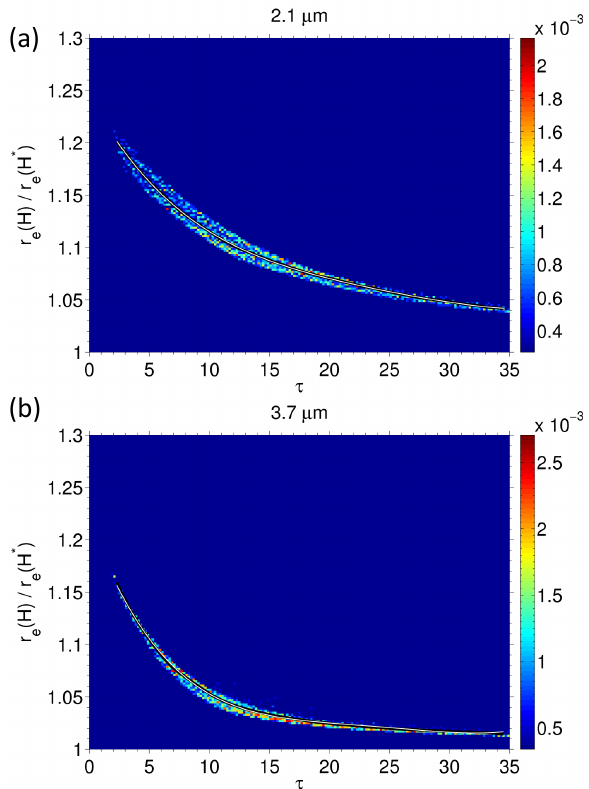
Figure 1. Two-dimensional histogram of g re as a function of τ for a range of clouds (see text) for the 2.1µm r e retrieval (a) and the 3.7µm retrieval (b) . The black line is the median g re in each τ bin after smoothing over τ interval windows of 0.2. The white line is the fit to the mean curve using Eq.